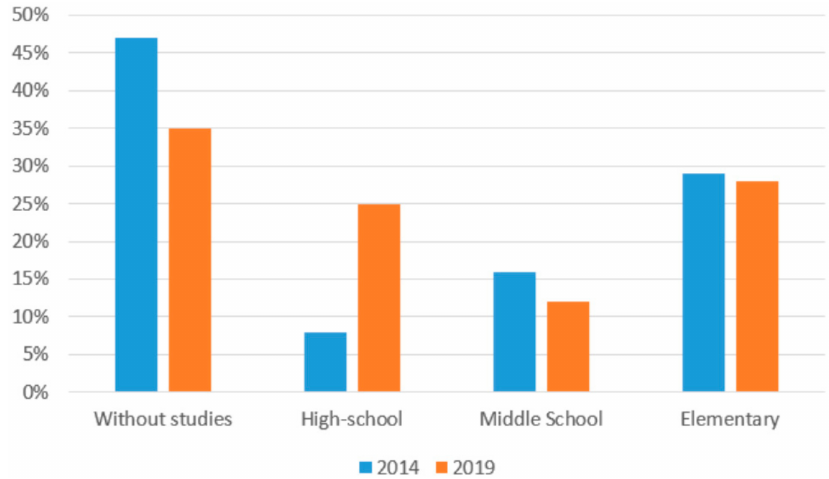
Figure 3. Education level of workers in fruit- and vegetable-processing companies. Source: Compiled by the authors.